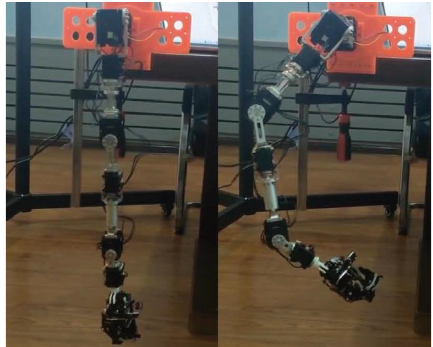
Figure 13: Te two confgurations of the SRL